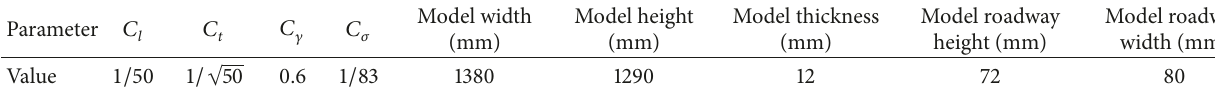
Table 1: Similarity model parameter design.